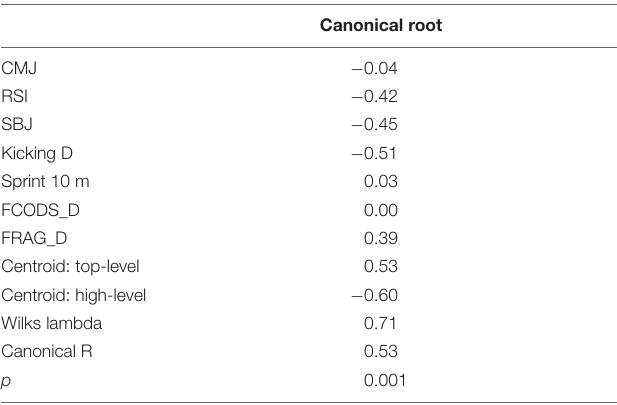
TABLE 5 | Multivariate differences between top-level players and high-level players in studied variables (forward stepwise discriminant canonical